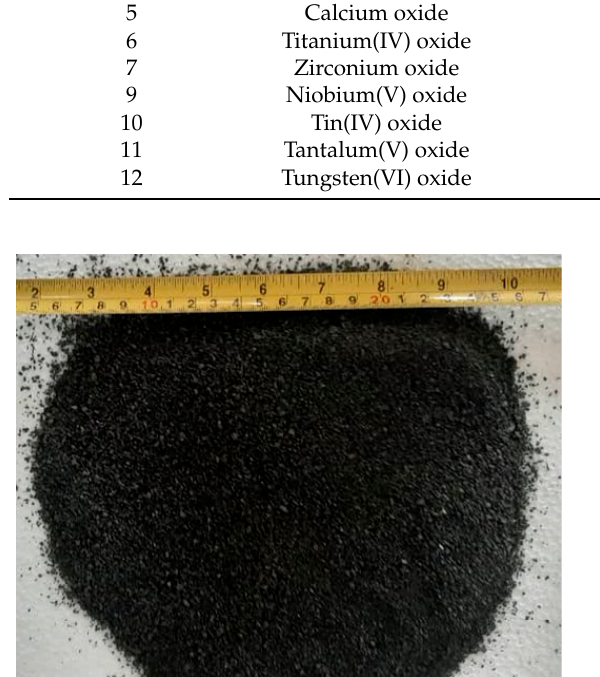
Figure 1. The macro morphology of tin slag.